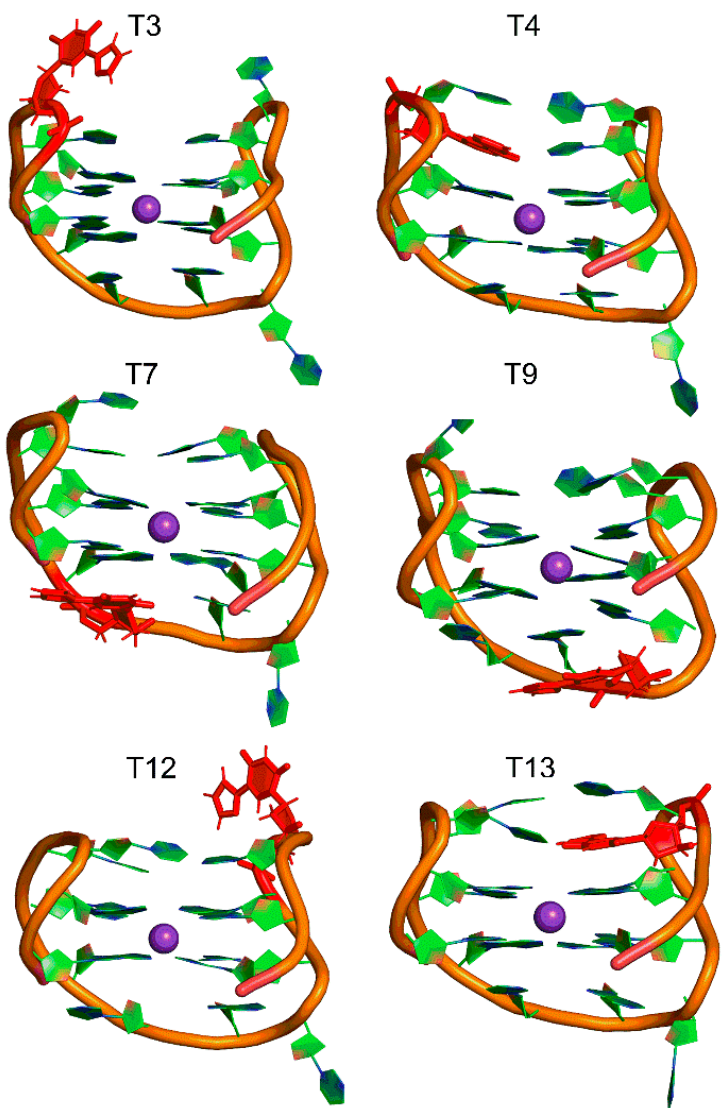
Figure 2. Representative MD structure of the unbound TBA containing 5FurU at positions T3, T4, T7, T9, T12 or T13 (red).